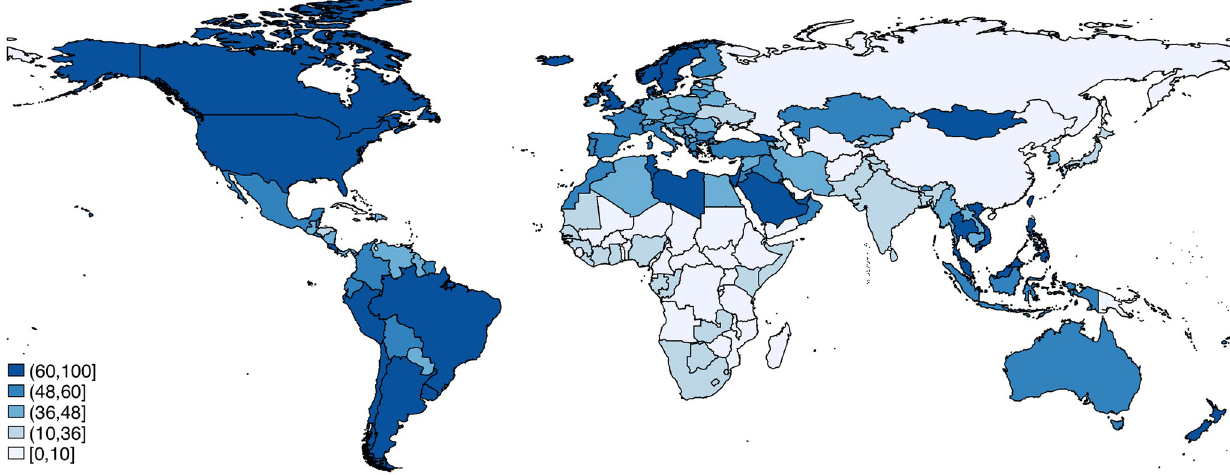
Fig 1. Percentage of population that is active on Facebook at least once per month (2019). Source for the data: World Population Review